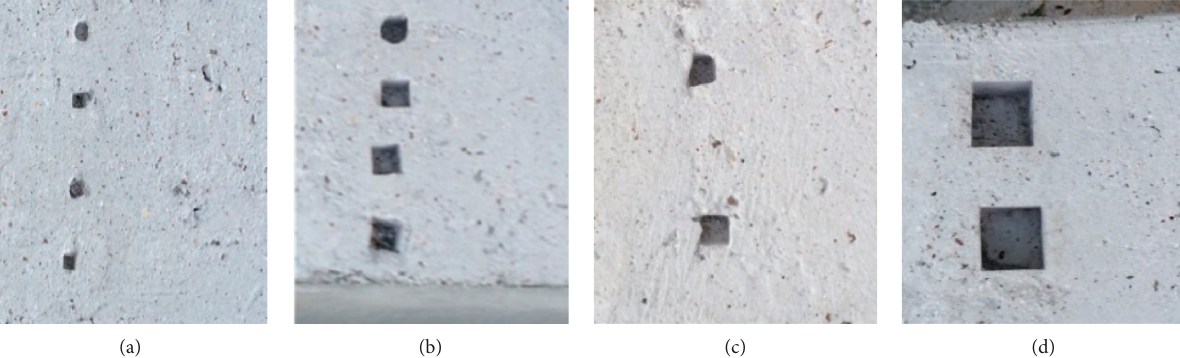
Figure 6: Surface voids. (a) Sample 3 (10.2 mm voids). (b) Sample 4 (20.3 mm voids). (c) Sample 5 (20.3 mm voids). (d) Sample 6 (40.5mm voids).